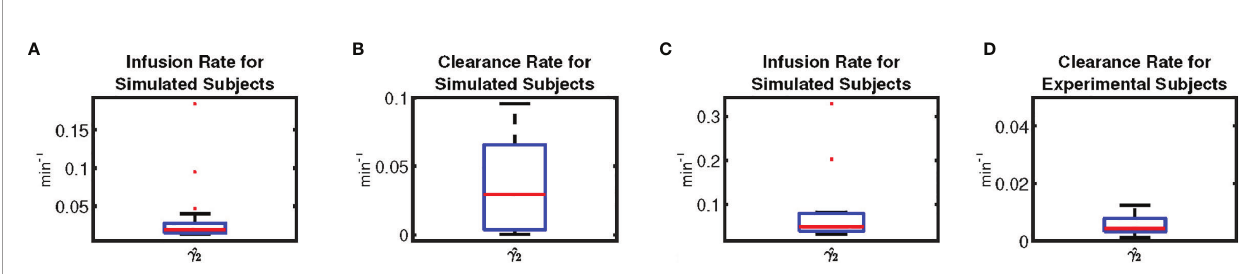
FIGURE 3 | Box-plot of Physiological Parameters of Leptin Levels. Subplots, respectively illustrate the sample distribution of (A) the infusion rate for simulated leptin data, (B) the clearance rate for simulated leptin data, (C) the infusion rate for experimental leptin data, and (D) the clearance rate for experimental leptin data, depicting the median (red line), the lower (Q1) to upper (Q3) quartile range (blue rectangle), and 9 to 91 percentile range (black line and black dashed line).